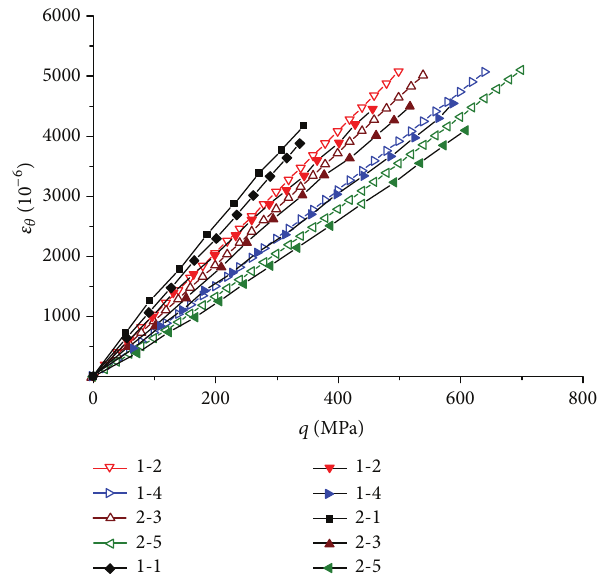
Figure 6: Comparison between the theoretical and experimental results on the 𝜀 𝜃 - 𝑞 relation of different